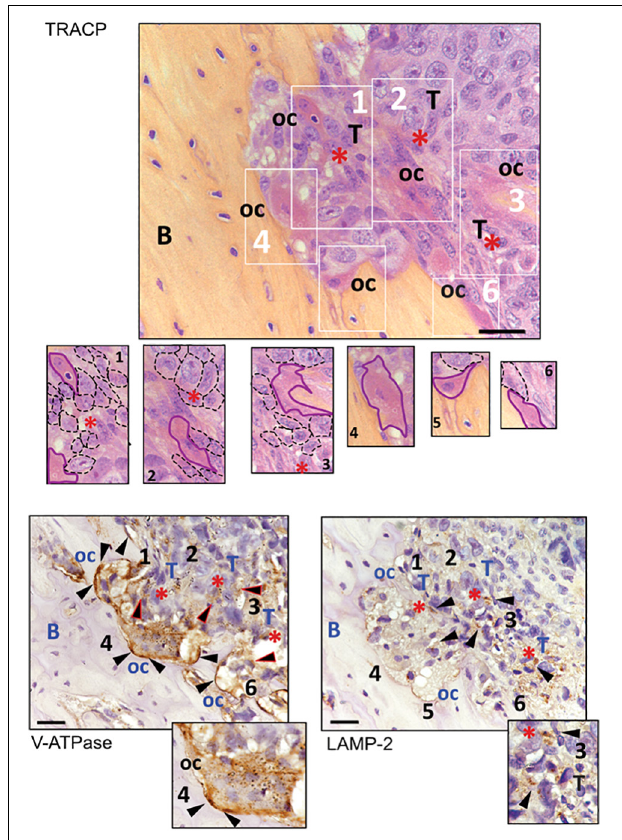
FIGURE 4 | Immunostaining for TRACP, V 1 B 2 V-ATPase, and LAMP2 in osteolytic area of bone metastasis (BM) xenografts. Representative pictures. In the upper panel, TRACP staining (bordeaux) enlighten the presence of multinucleated osteoclasts (nuclei were counterstained with Mayer’s hematoxylin). At the bottom, V-ATPase and LAMP2 staining of subsequent sections of the same sample (B, bone; oc, osteoclasts; T, area rich in tumor cells; red asterisks, supposed acidic area since they showed LAMP2-positive carcinoma cells; black triangles, positive signal for the respective antigen). In the image corresponding to TRACP staining, six different areas, identified with white numbers and rectangles, are also shown at higher magnification (osteoclasts have been contoured with continuous purple lines, whereas cancer cells were contoured with dark dotted lines). The same numbers have been used to identify the same area of the tumor in the subsequent tissue sections. Both osteoclasts and tumor cells showed to be positive for V-ATPase, although to a lower degree in tumor cells (triangles with red perimeters). Furthermore, the area with LAMP2 staining in carcinoma cells appeared to be very close to actively resorbing bone (scale bar 10 µ